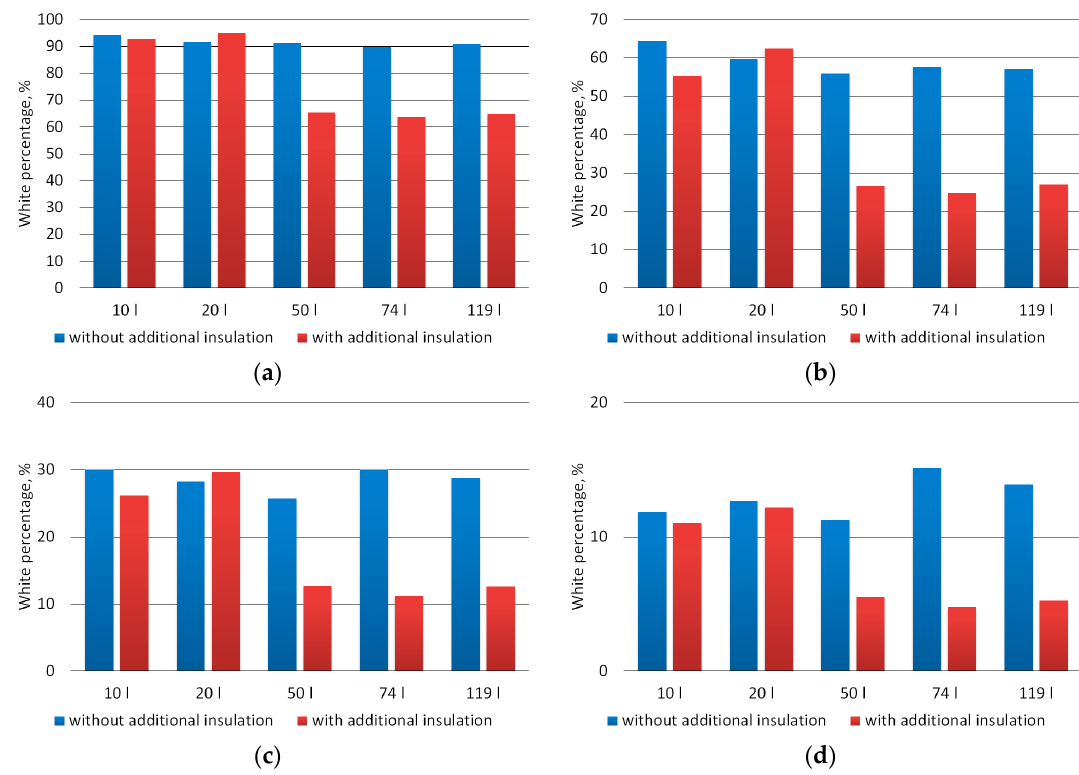
Figure 7. Percentage of white color averaged for images of composted material subjected to binarization ( a )—threshold 0.05, ( b )—threshold 0.10, ( c )—threshold 0.15, ( d )—threshold 0.20.